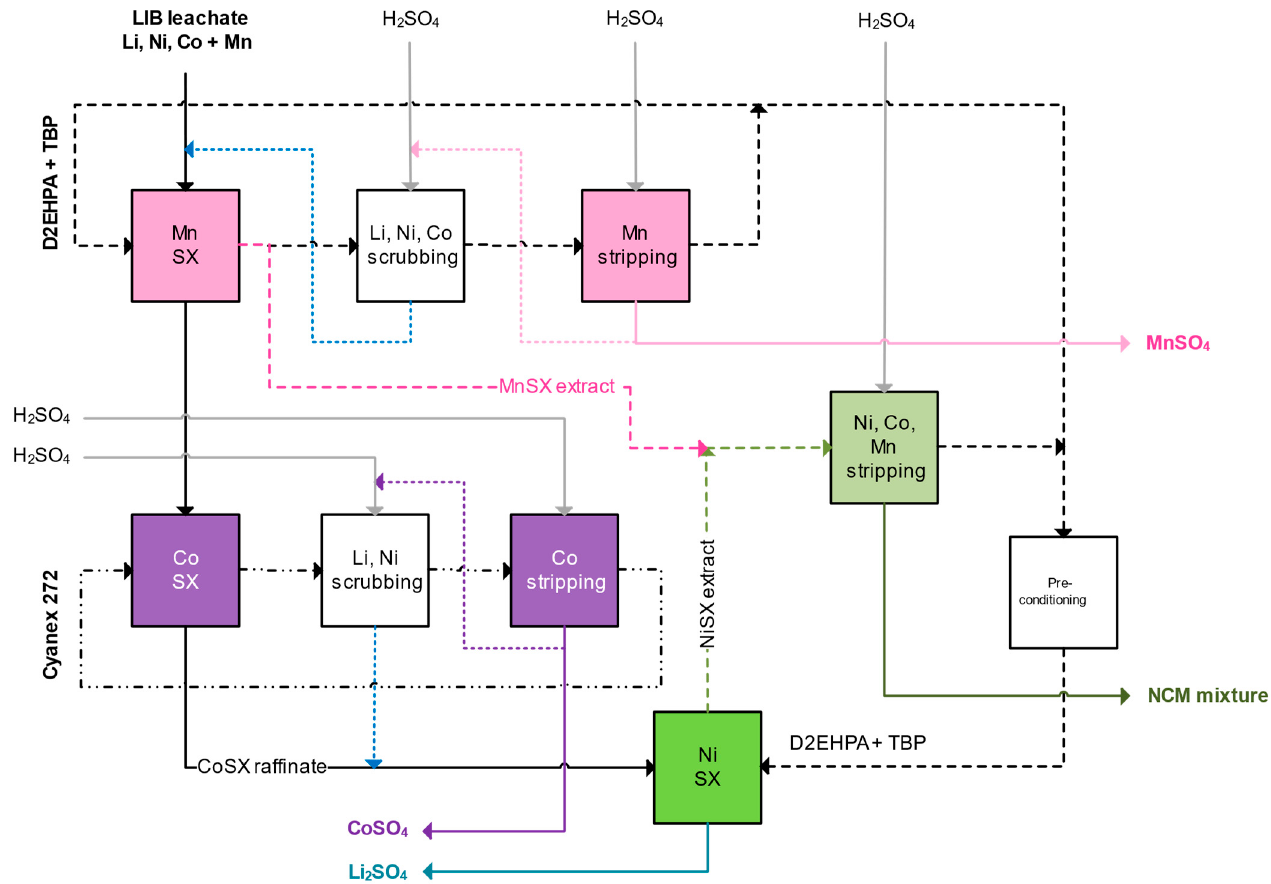
Figure 1. A simplified diagram of a solvent extraction process for the processing of lithium-ion battery leachates. The blocks studied in this work are colored. Dashed line = D2EHPA stream (organic), dashdot line = Cyanex 272 stream (organic), solid line = aqueous stream, dotted line = bleed-off from stripping raffinate (aqueous).